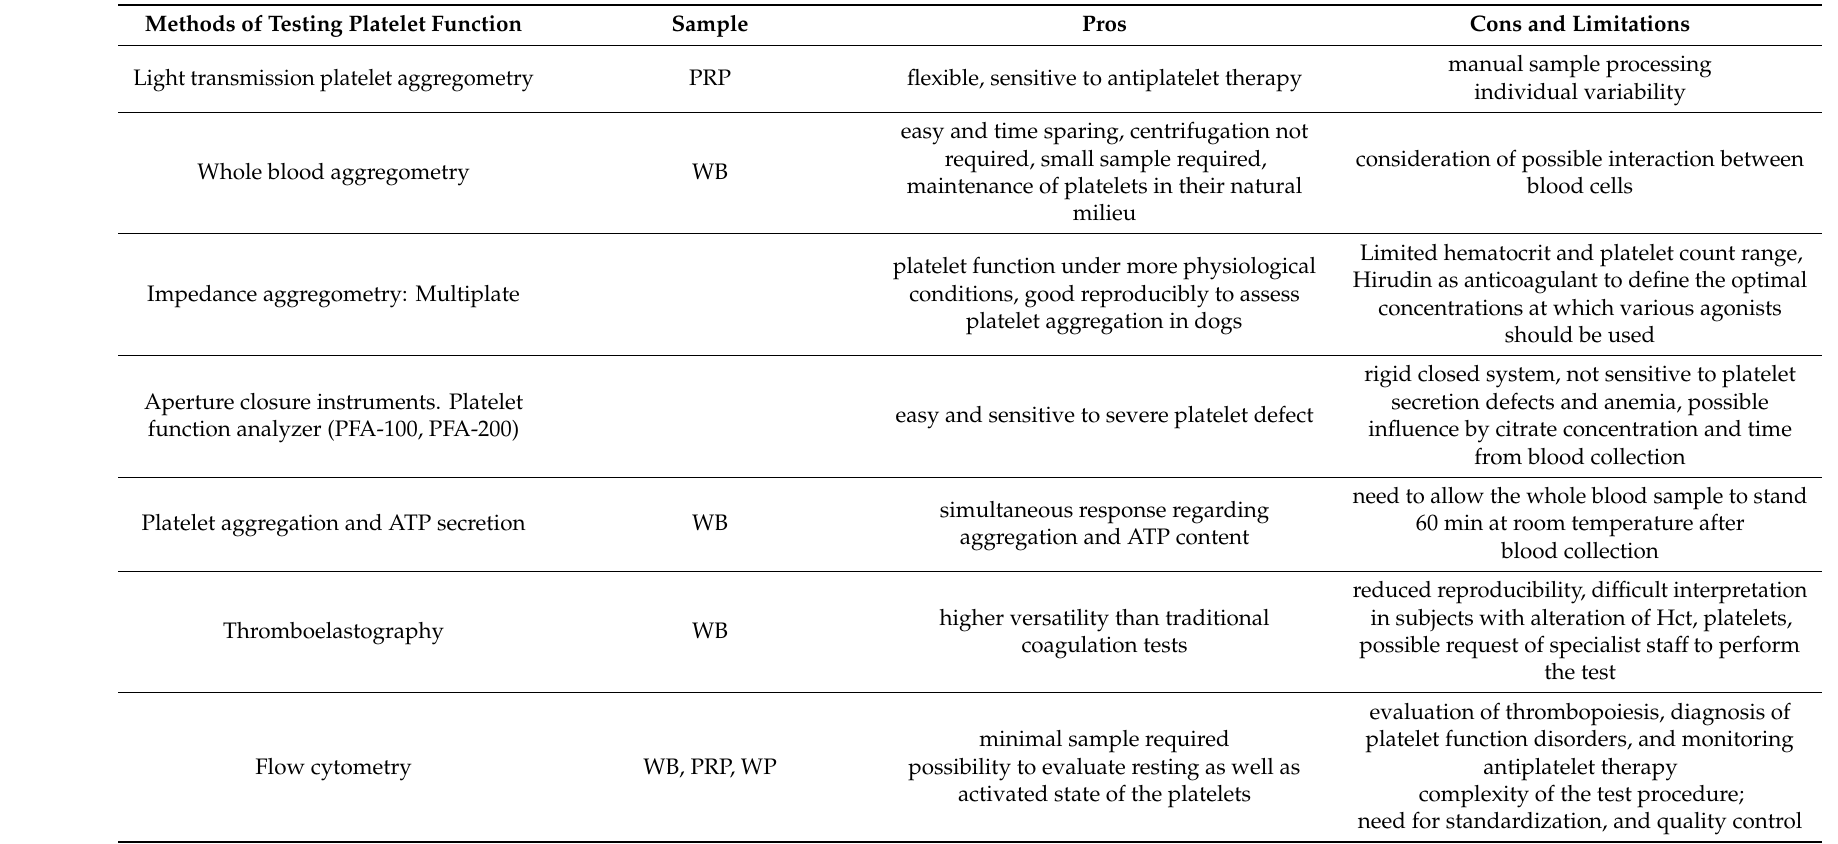
Table 3. List of methods to test canine platelet